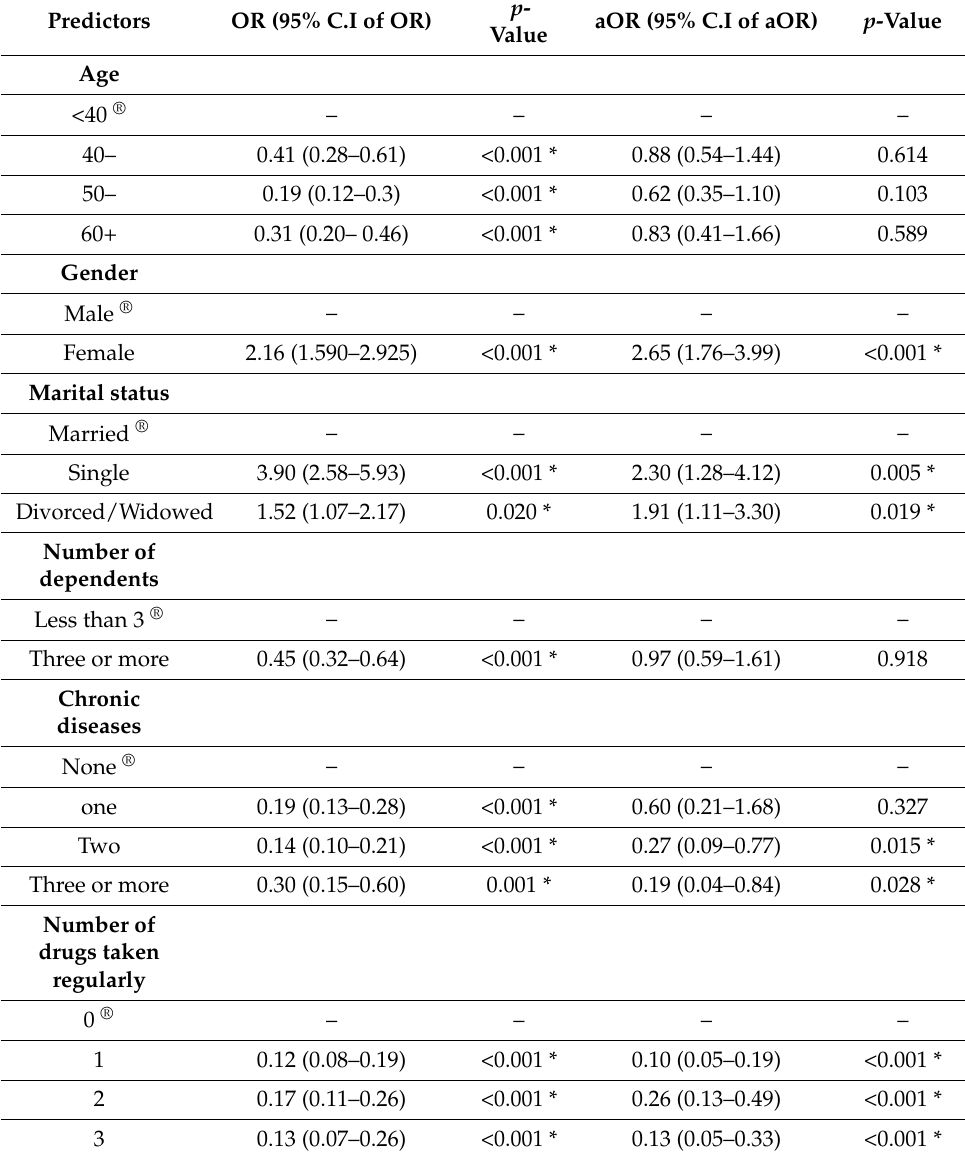
Table 3. Logistic regression analysis for the predictors of using out-of-network care in the NHIF of Al Jazirah State in